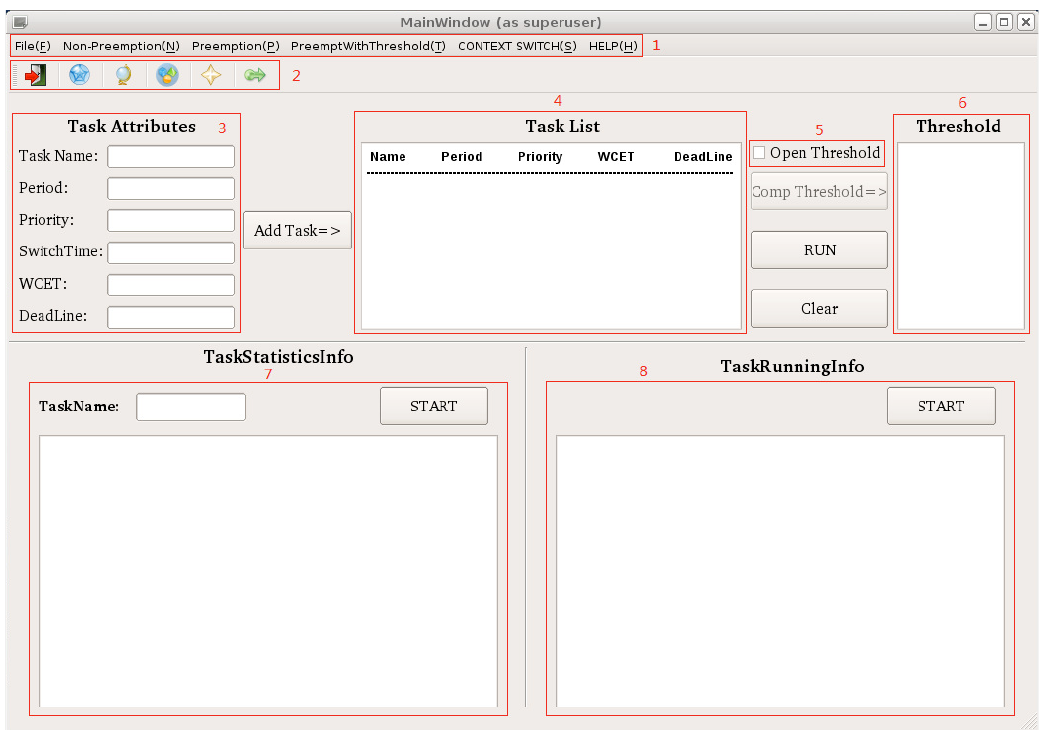
Figure 1. Worst-case response time (WCRT) analysis